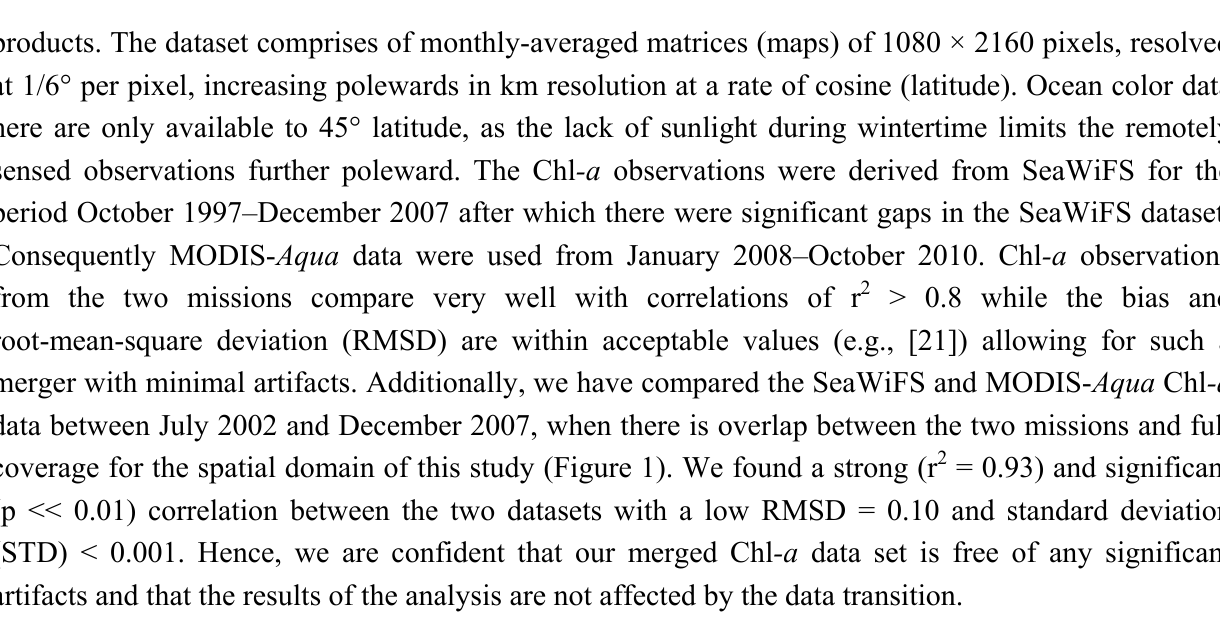
Figure 1. Comparison of SeaWiFS and MODIS- Aqua Chl -a monthly data from July 2002–December 2007, 20°N to 45°S, 140°E to